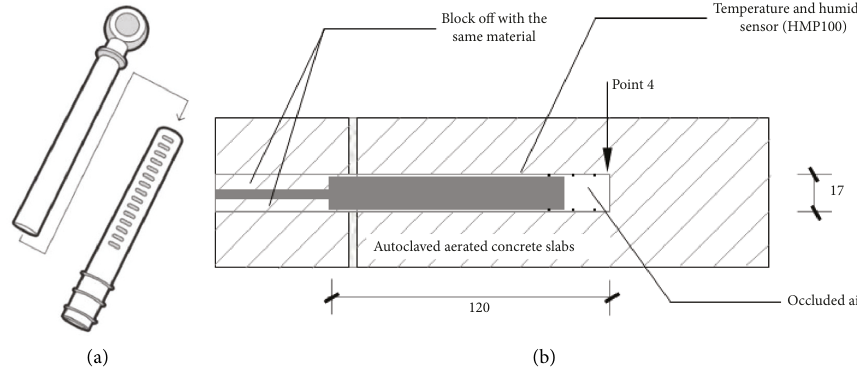
Figure 5: Installation method for sensors inside external wall mortar layer. (a) Embolize the long rubber into the plastic pipe. (b) Detailed construction drawing of sensor inside the mortar layer (/mm, point